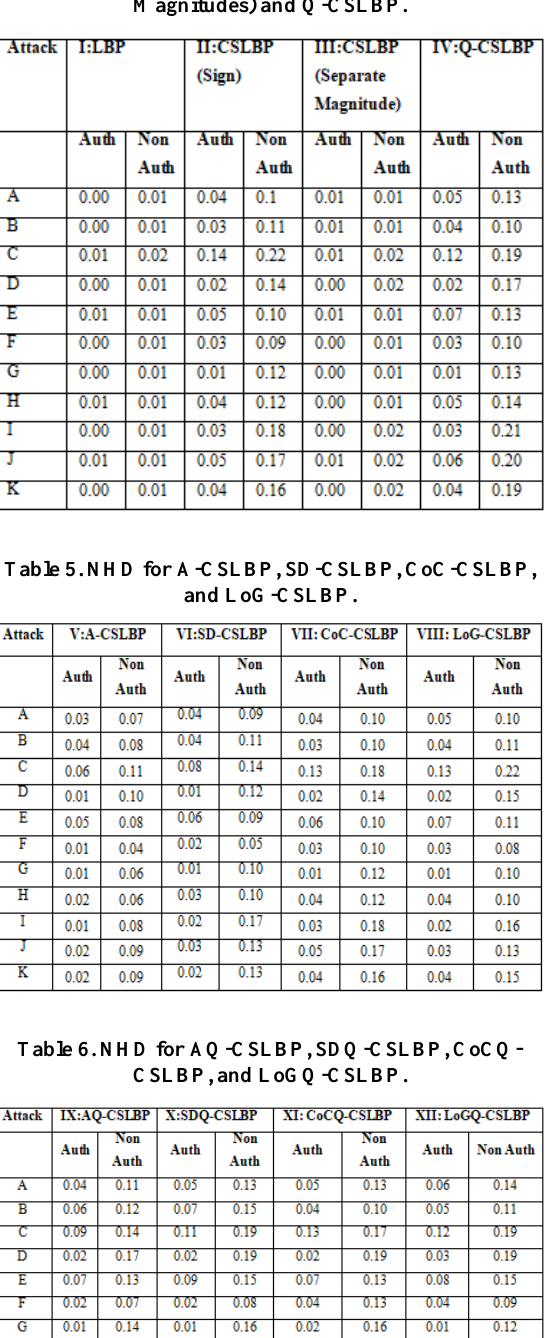
Table 4. NHD for LBP, CSLBP (Sign), CSLBP (Separate Magnitudes) and